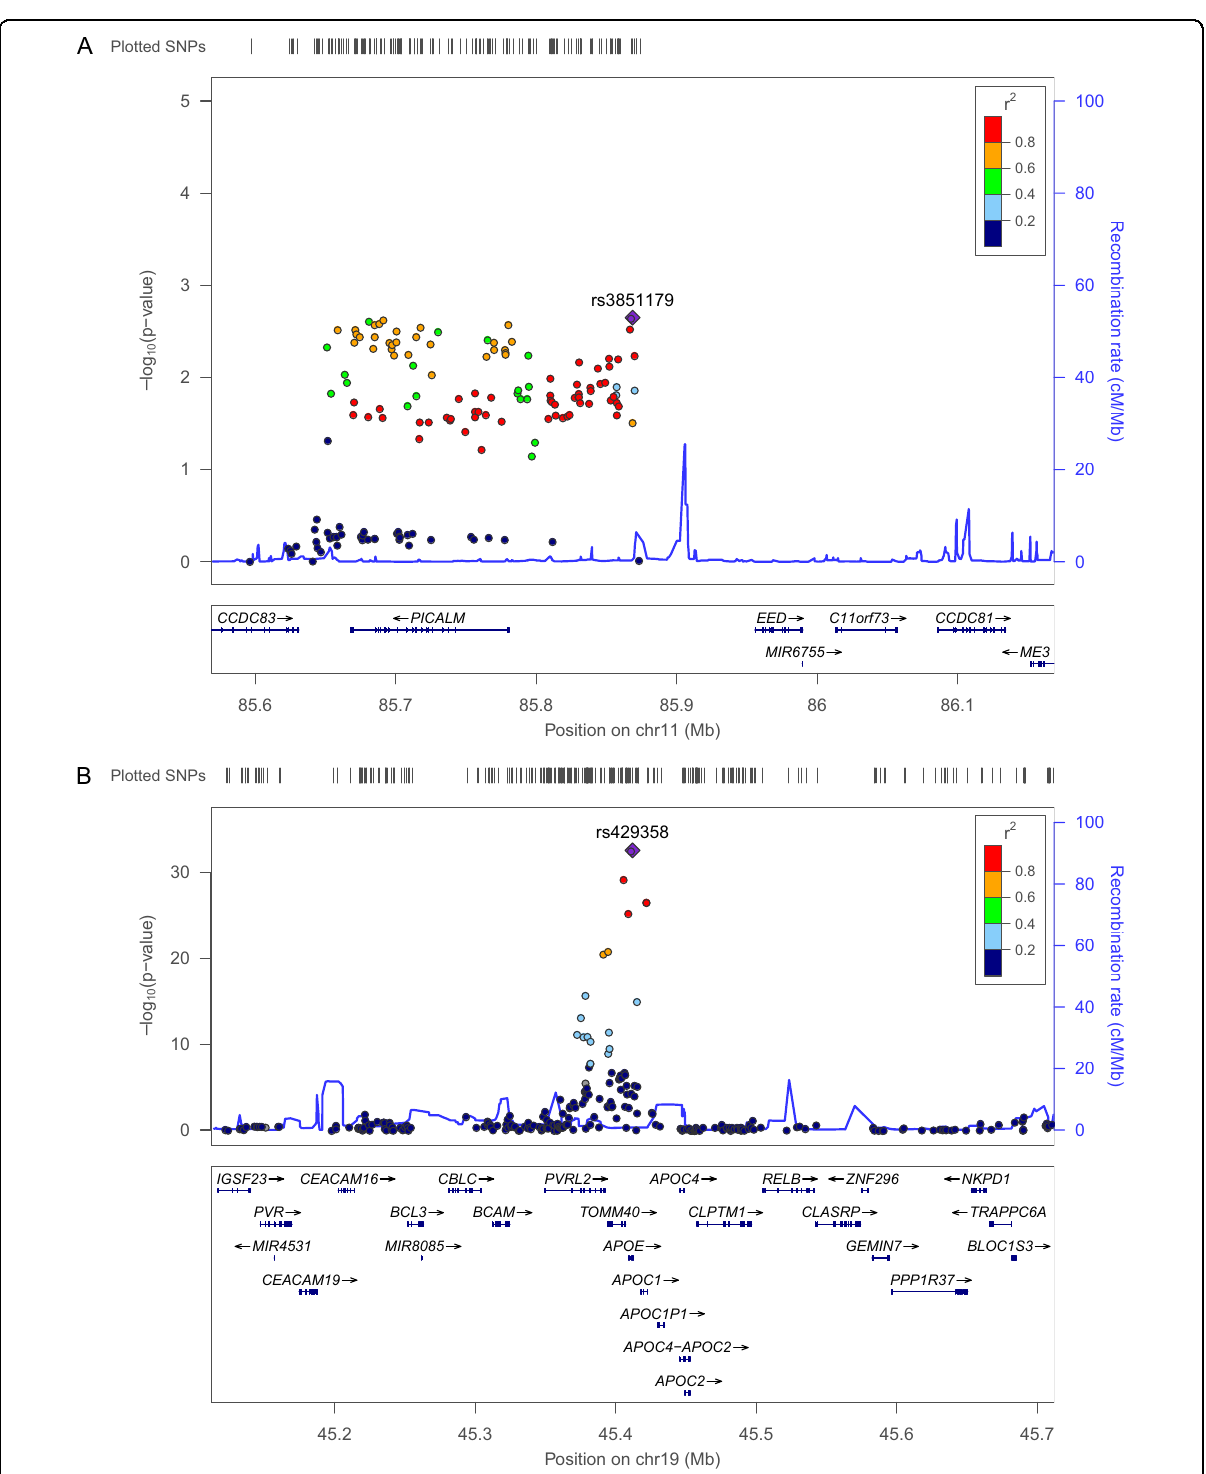
Fig. 2 Regional plot of known loci (11q14.2; PICALM and 19q13.32; APOE ) that are signi fi cantly associated with Alzheimer ’ s disease (AD) in the cAD chip application set. The fi gures show the regional association plot of known representative loci, ( A ) 11q14.2; PICALM and ( B ) 19q13.32; APOE , in the cAD chip application set ( n = 1,437). The purple shaded diamond shape represents rs3851179 and rs429358, which are the most signi fi cant SNPs in 11q14.2 ( A) and 19q13.32 ( B ), respectively. The blue line indicates the recombination rate, while fi lled color represents the linkage disequilibrium score based on r 2 values estimated from the 1000 genome Nov 2014 ASN